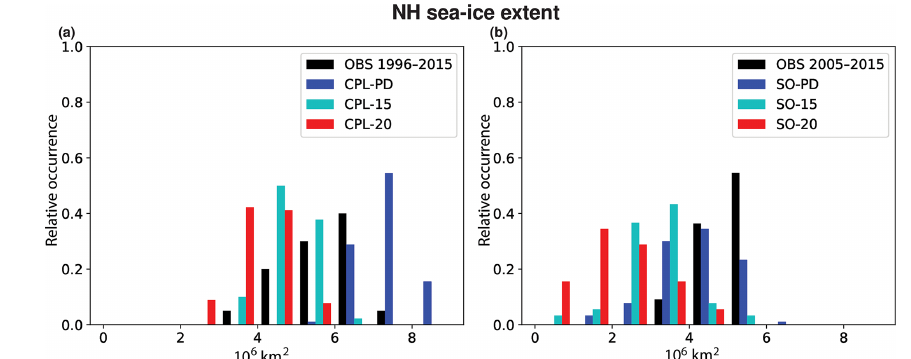
Figure 20. The relative occurrence of NH monthly-mean sea-ice extent in September for observations (black bars; OSI-SAF, 2017), the PD experiments (blue bars), and the 1.5 ◦ C (green bars) and 2.0 ◦ C warming experiments (red bars) from NorESM1-Happi (a) and NorESM1- HappiSO. The sea-ice extent is binned in 1 . 0 × 10 6 km 2 increments. The observations are from 1996 to 2015 (20 values) in panel (a) and from 2005 to 2015 (11 values) in panel (b) . The values from NorESM1-Happi and NorESM1-HappiSO are from the default 90-year periods (Sect. 3.2). Units are in 10 6 km 2 (a, b)